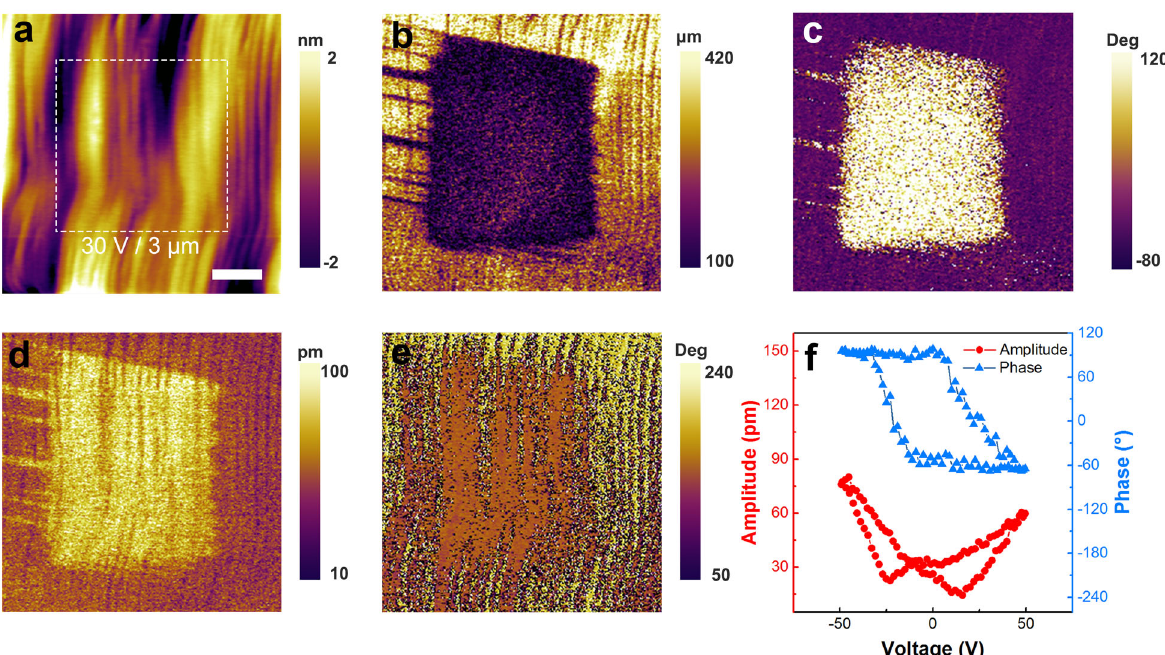
Fig. 2 Ferroelectric properties of the DIPAB/CuPc heterostructure. a Surface morphology of a DIPAB fi lm which was symmetrically poled by a + 30 V tip bias in the squared area with a size of 3 μ m. b – e LPFM amplitude, LPFM phase, VPFM amplitude, and VPFM phase images of the squared area. f Phase-voltage hysteresis (blue) and butter fl y shape amplitude-voltage hysteresis (red) loops. Scale bar is 1 μ